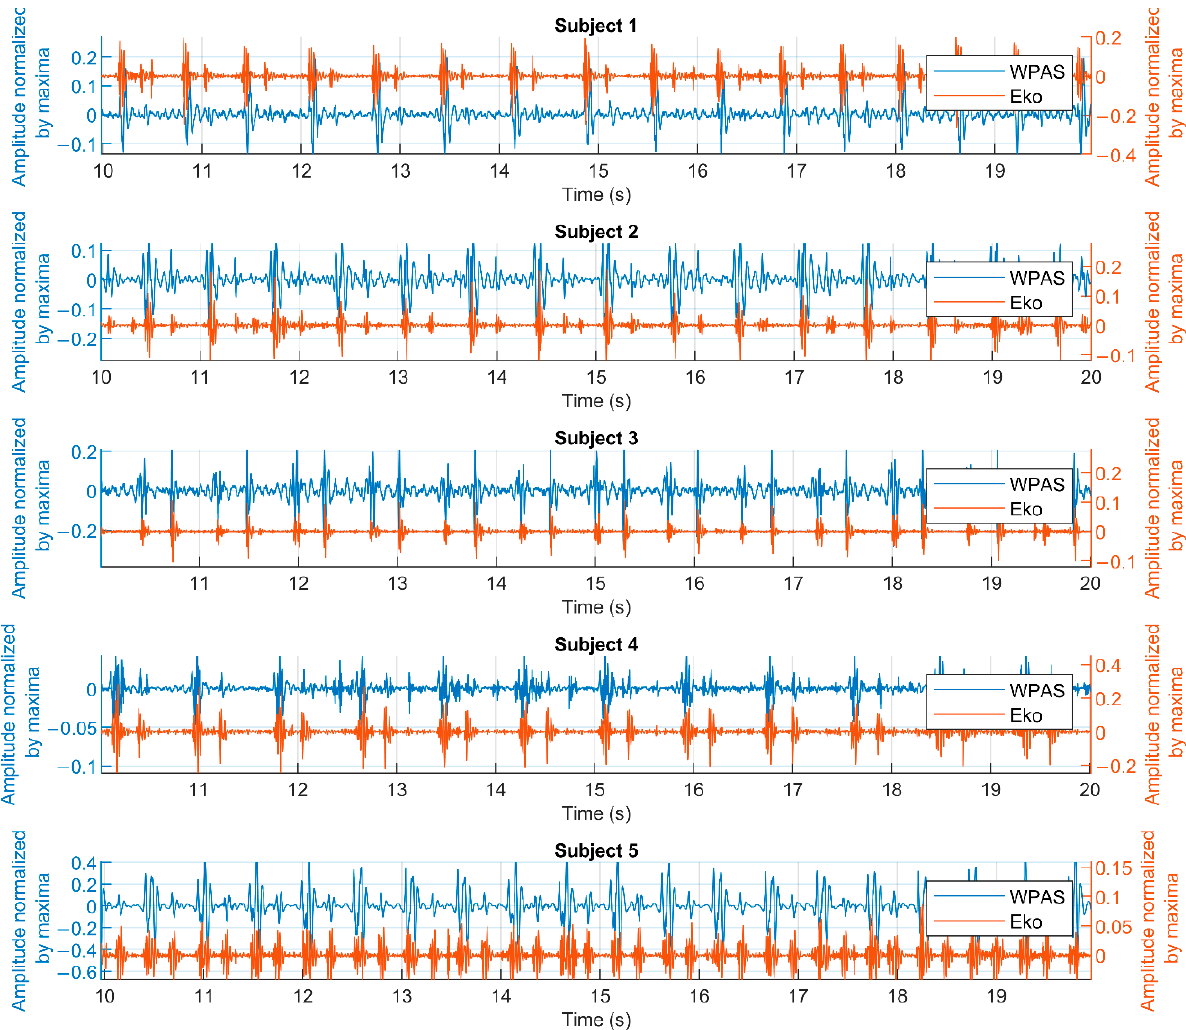
Figure 9. Time-synchronized occurrence of S1 and S2 as captured by Eko Core device and WPAS.